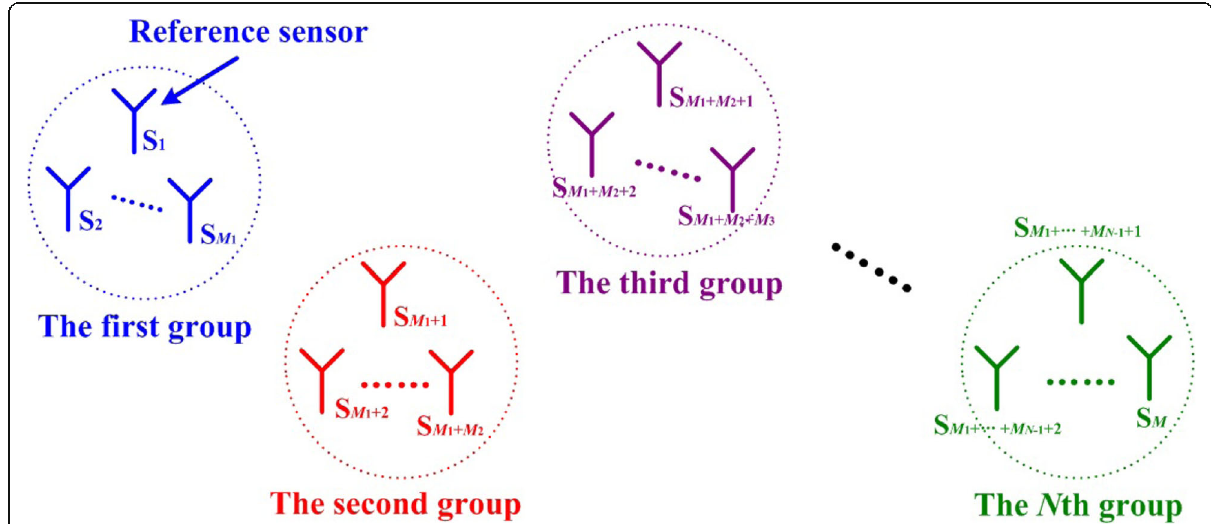
Fig. 1 Sketch map of sensor